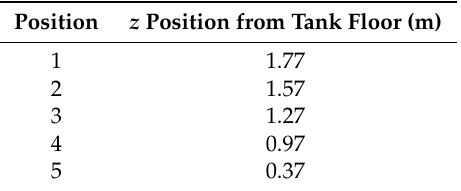
Table 2. Acoustic Doppler Velocimeter (ADV) z -positions.